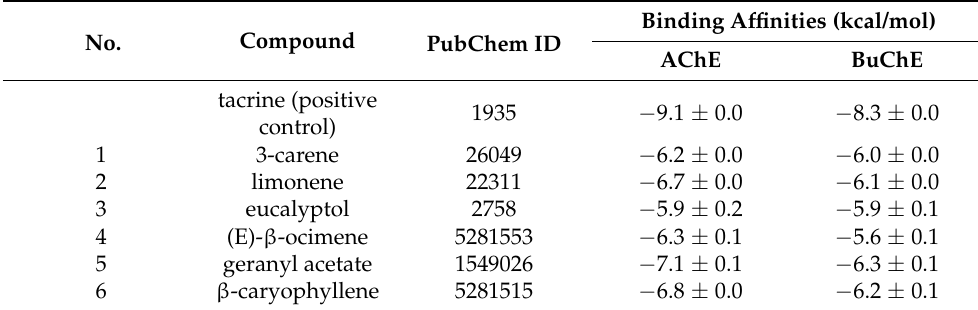
Table 6. Binding affinities of six major compounds in the LGFEO against acetylcholinesterase (AChE) and butyrylcholinesterase (BuChE).